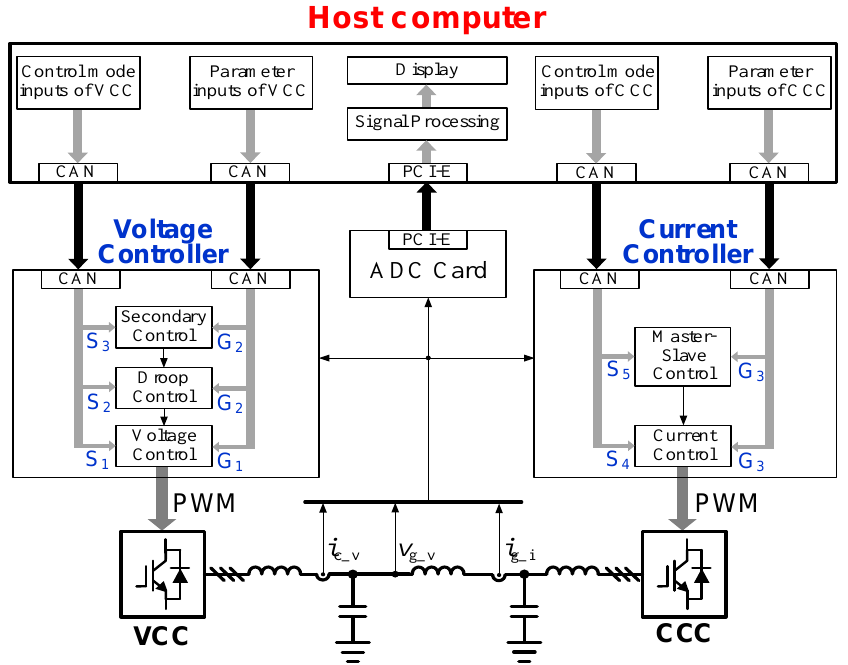
Figure 4. Configuration of the user interface in the host computer. VCC: voltage-controlled con- verter, CCC: current-controlled converter.